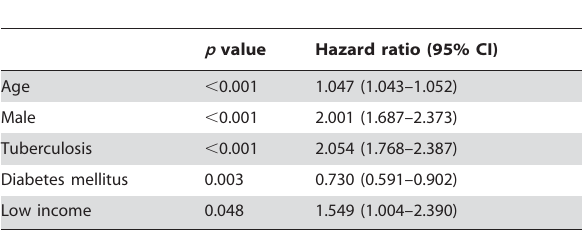
Table 2. Independent risk factors for developing COPD in pulmonary tuberculosis patients (n=3176) and control subjects (n=15880), by Cox proportional hazards regression